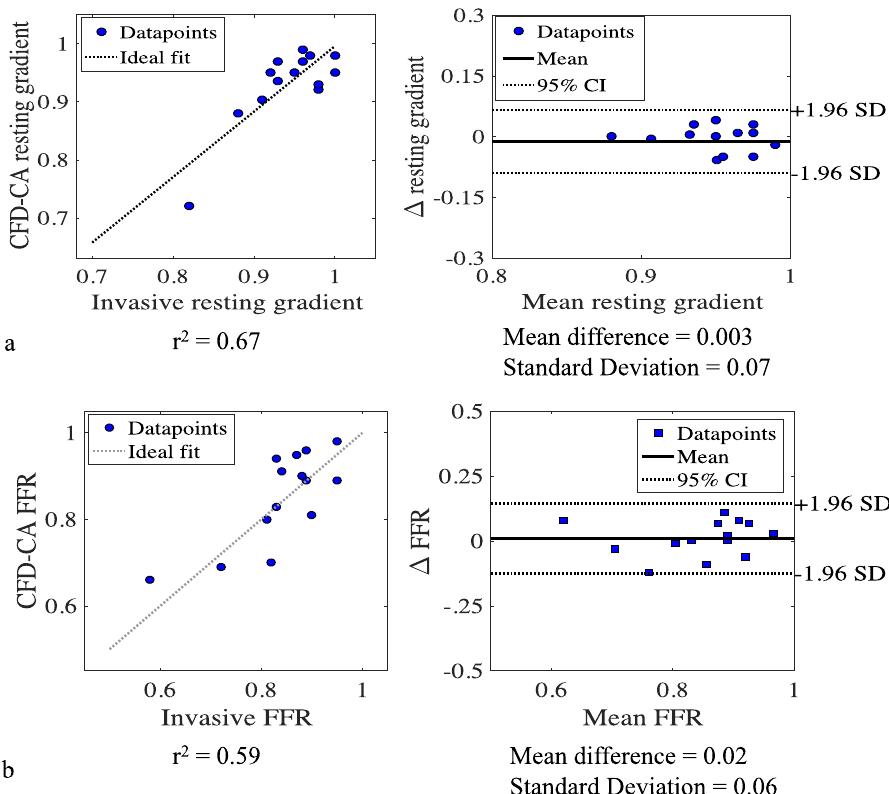
Figure 3. ( a ) Correlation between invasive resting gradient and CFD-CA resting gradient (left) and corresponding different plot determined from Bland Altman analysis (right). ( b ) Correlation between invasive FFR and CFD-CA FFR (left) and corresponding different plot determined from Bland Altman analysis